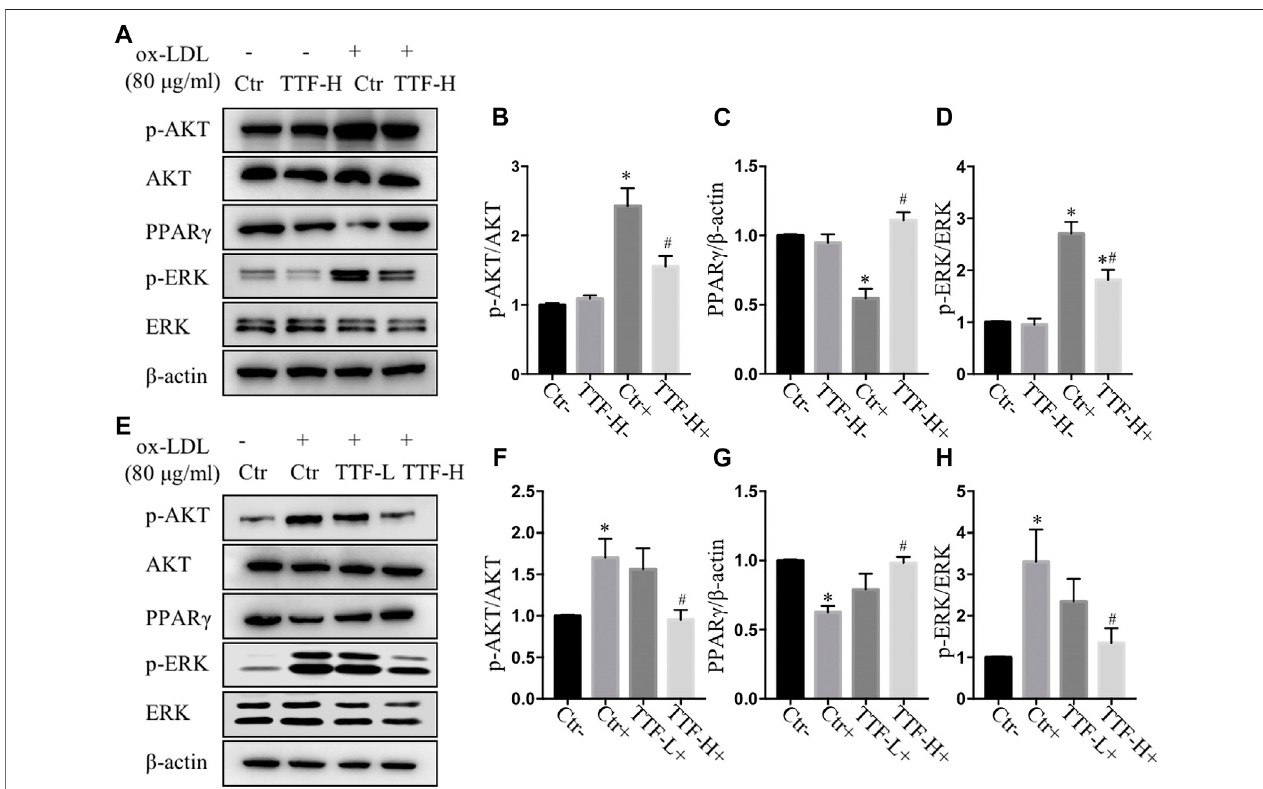
FIGURE8 | TTF affected atherosclerotic plaquethrough AKT, ERK and PPAR γ signal (A) Westernblotting showed the protein expression ofp-AKT, AKT, PPAR γ , p-ERK,andERKinPMcellstreatedwithPBSandTTF(0.5 mg/ml)stimulatedwithox-LDL(80 μ g/ml) (B – D) Thequantitativeanalysisofgreyratioofp-AKT/AKT,PPAR γ / β -actin, and p-ERK/ERK (E) Western blotting showed the protein expression of p-AKT, AKT, PPAR γ , p-ERK, and ERK in PM cells treated with PBS and TTF (0.25, 0.5 mg/ml)stimulatedwithox-LDL(80 μ g/ml) (F – H) Thequantitativeanalysisofgreyratioofp-AKT/AKT,PPAR γ / β -actin,andp-ERK/ERK.Valuesarepresentedas means ± SEM (n (cid:2) 3 per group). * p < 0.05 vs Ctr-group, # p < 0.05 vs Ctr +